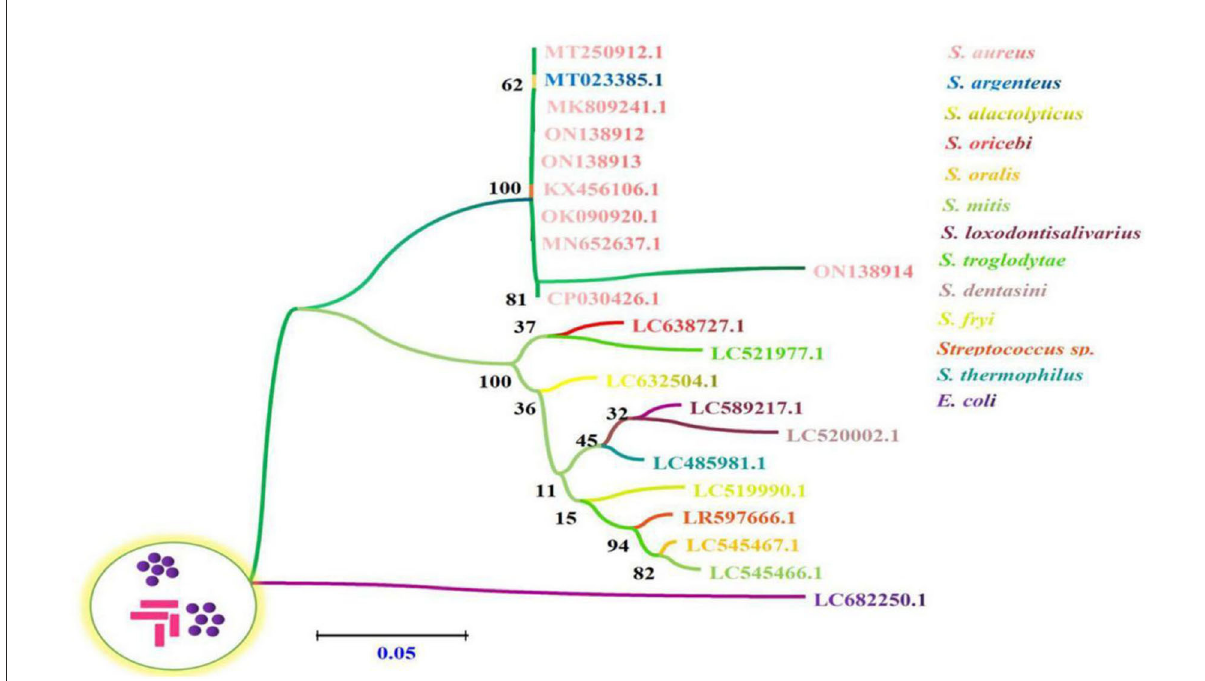
FIGURE2 The phylogenetic relationships of 16s rRNA gene between S. aureus sequences derived from bovine milk samples and reference sequences by employing a Neighbor-Joining (NJ) method via Kimura two-parameter analysis. The number of nodes indicates the bootstrap values. Bootstrap values > 50% from 1,000 replicates are shown on the